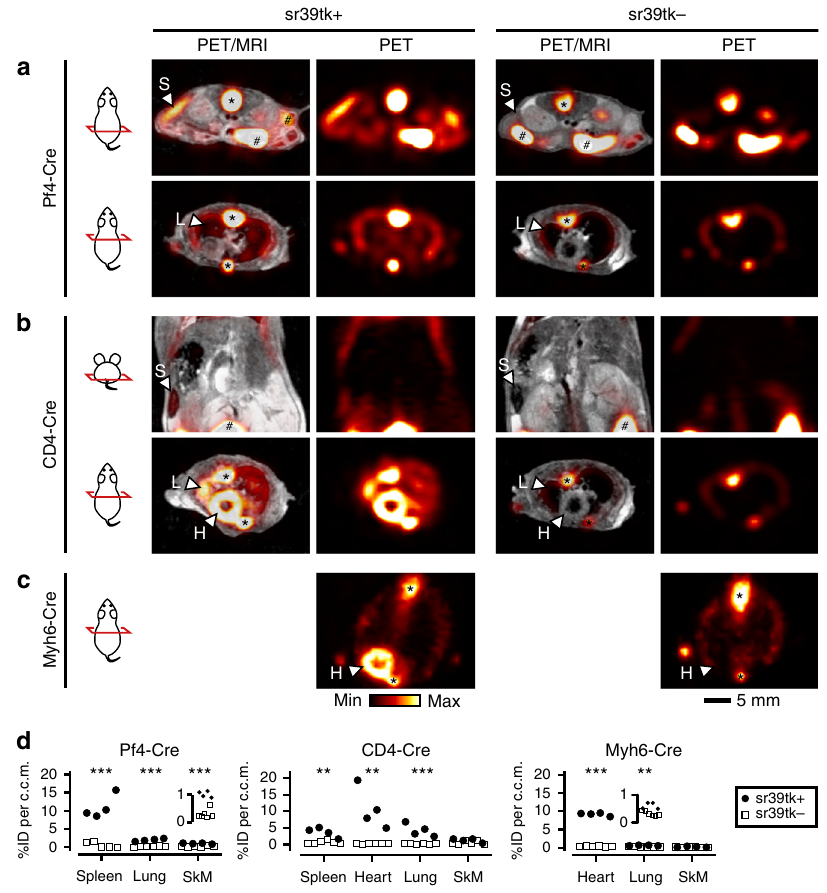
Fig. 2 In vivo analysis of [ 18 F]FHBG uptake in mice with different sr39tk-expression pro fi les. Panels show representative [ 18 F]FHBG-PET images of sr39tk- expressing mice (sr39tk+; genotype: Cre[tg/+],R26[sr39tk/+]) and Cre-negative control animals (sr39tk − ; genotype: Cre[+/+],R26[sr39tk/+]); ‘ + ’ denotes the wild-type allele. To con fi rm uptake into distinct anatomic locations, MR images were recorded and overlaid with PET images (PET/MRI). Nonspeci fi c signals that were observed in both sr39tk+ and sr39tk − animals originate from the bone (*) and gastrointestinal tract (#). Speci fi c